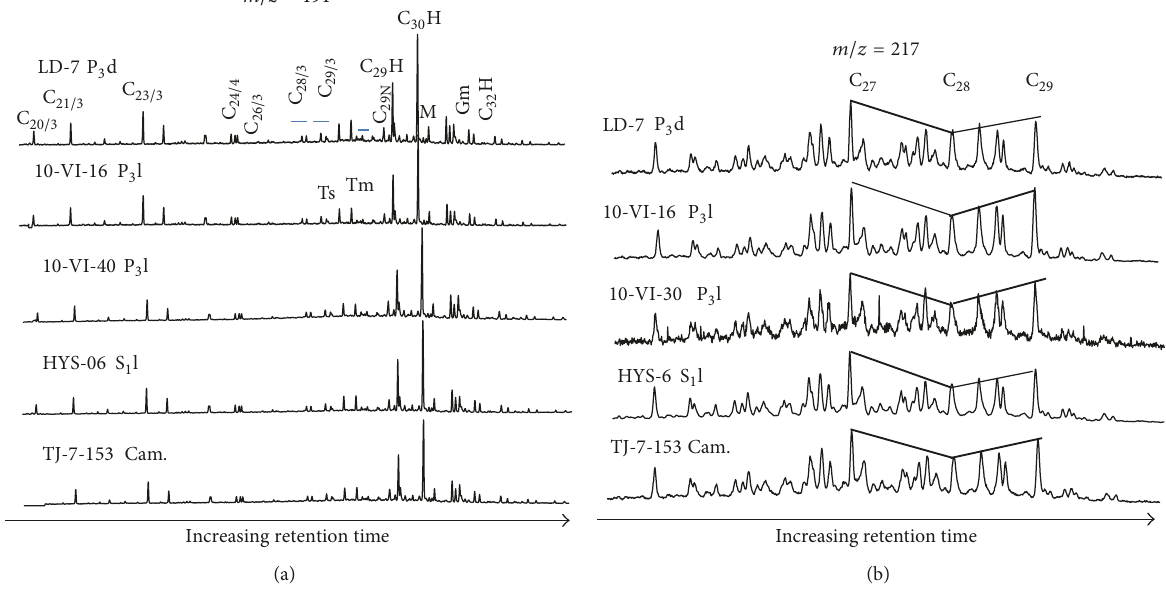
Figure 2: Partial GC-MS chromatograms ( 𝑚/𝑧 = 191 and 217) for extractable organic matter from the Upper Permian Dalong Fm (LD-7) and Longtan Fm (10-VI-16, 10-VI-40), Lower Silurian (HYS-06), and Lower Cambrian (TJ-7-153) (28/3 is C 28 tricyclic terpane and M is moretane; see note in Table 3 for other